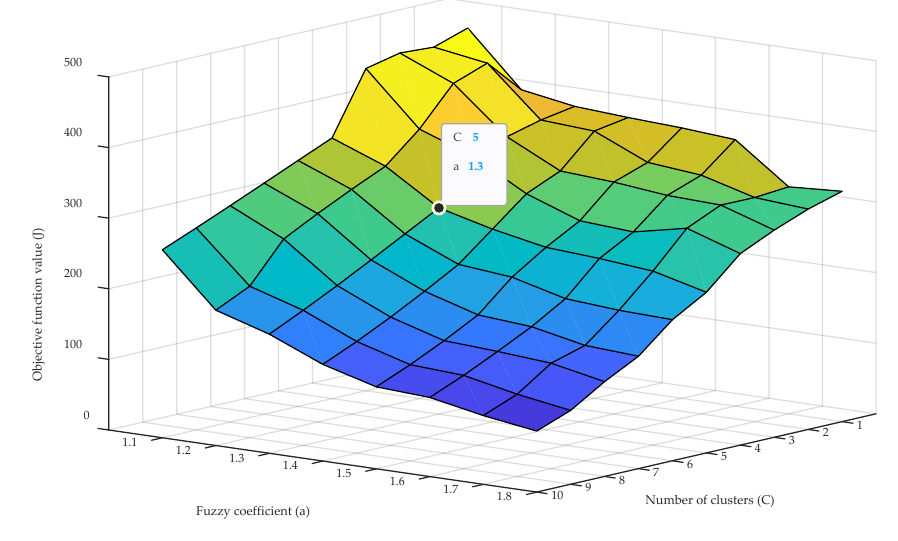
Figure 5. Parameter search process.